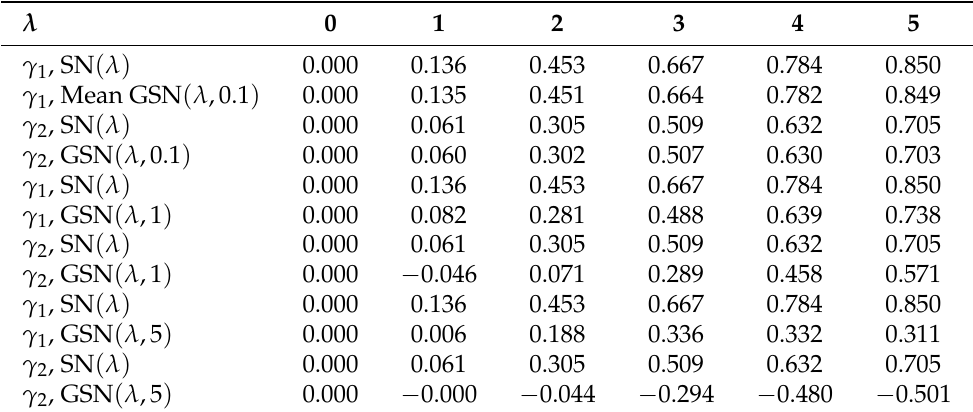
Table 2. Third and fourth standardized cumulants of the GSN and the SN variates for some parame- ter